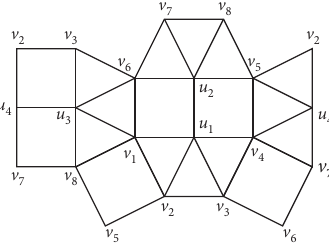
Figure 6: Doubly semiequivelar map on torus of type T 3 2 , 4, 3, 4] 1 .